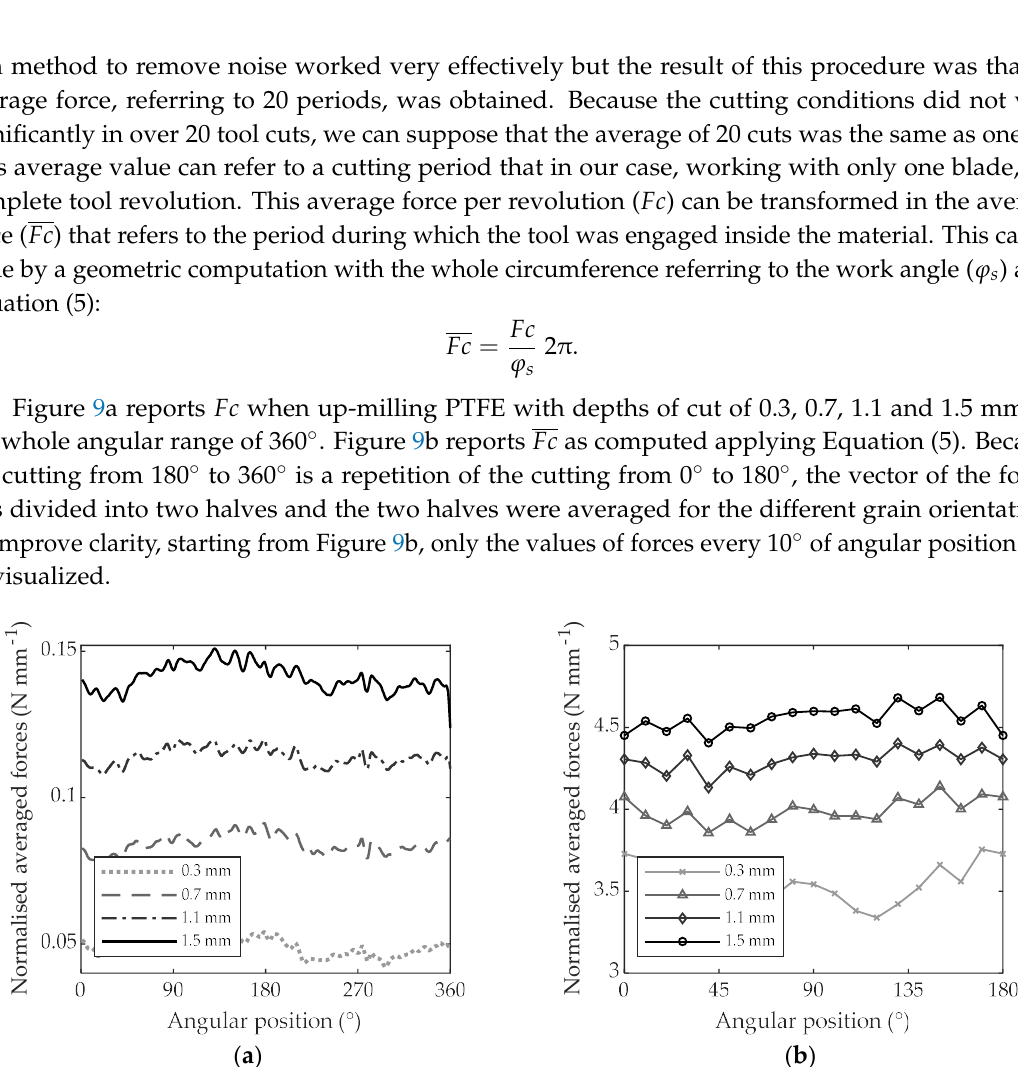
Figure 10. Specific cutting coefficient ( 𝐾𝑠 ) and intercept when machining PTFE: ( a ) with 0.3, 0.7, 1.1 and 1.5 mm of depth of cut computed at 90° grain orientation; ( b ) gathered for every 10°-grain orientation. Table 2. Average specific cutting coefficient ( 𝐾𝑠 ) and intercept values computed when machining PTFE with the up-milling technique. Variable